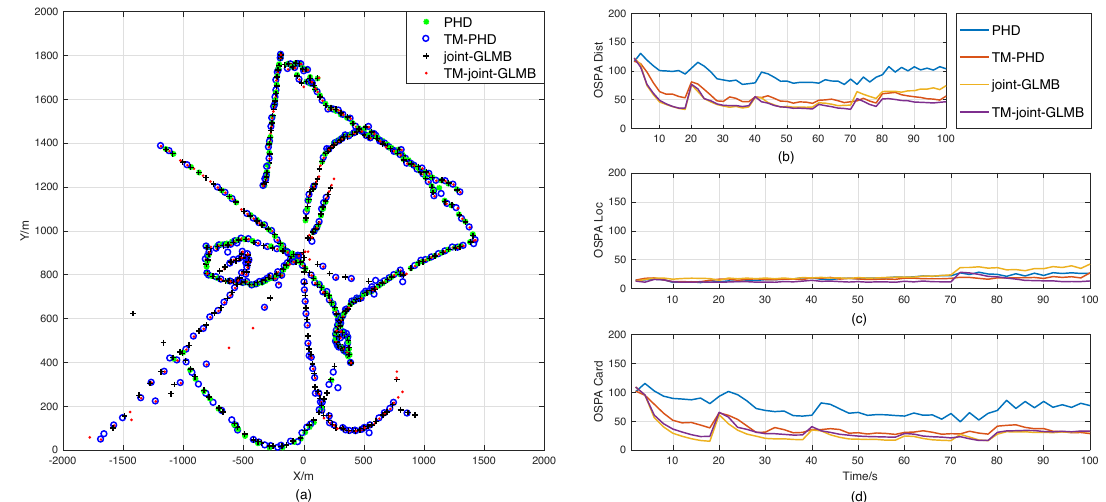
Figure 6. Result comparisons in Scenario 3. ( a ) Position estimations of the original RFS-based filters and the time-matching filters in one trial. ( b ) OSPA errors. ( c ) Location components of OSPA. ( d ) Cardinality components of OSPA.